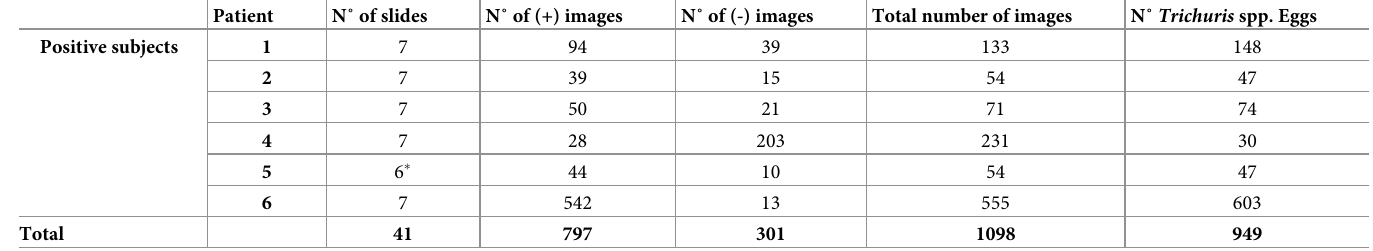
Table 1. Database of digitized Kato-Katz slide samples from the 6 positive patients. � Patient number 5 had 6 slides instead of 7 because one of them broke during its handling. Patient